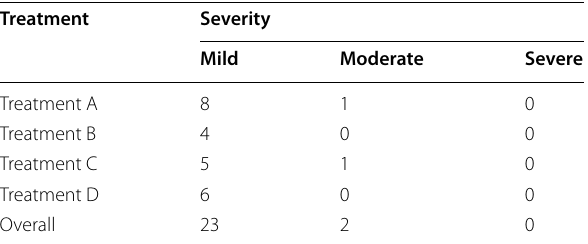
Table 6 Frequency of treatment‑emergent adverse events by severity Treatment